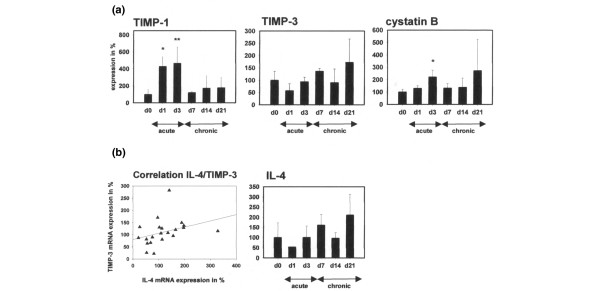
Real-time polymerase chain reaction (PCR) analyses of tissue inhibitor of metalloproteinases (TIMP)-1, TIMP-3, cystatin B and anti-inflammatory interleukin (IL)-4 expression in murine knee joints during the course of antigen-induced arthritis. Total RNA was isolated from murine right knee joints before (d0) and after (d1–d21) arthritis induction. After reverse transcription of mRNA, the expression of TIMP-1, TIMP-3, cystatin B and IL-4 was measured by real-time PCR. The housekeeping gene β-actin was used for normalization of expression. Three (n = 3) (days 1, 7 and 21) or five (n = 5) (days 0, 3 and 14) animals were analyzed by real-time PCR with Rotorgene 2000 (except IL-4, for which n was 3 for all investigated days). The mean of day 0 expression was set at 100%. Results are expressed as means and SEM. Significant changes in comparison with day 0 animals are indicated by asterisks (* P ≤ 0.05, ** P ≤ 0.01). (a) TIMP-1, TIMP-3 and cystatin B mRNA expression, and (b) anti-inflammatory IL-4 mRNA expression in knee joints significantly correlates with TIMP-3 mRNA expression according to Spearman's rho (P ≤ 0.01).